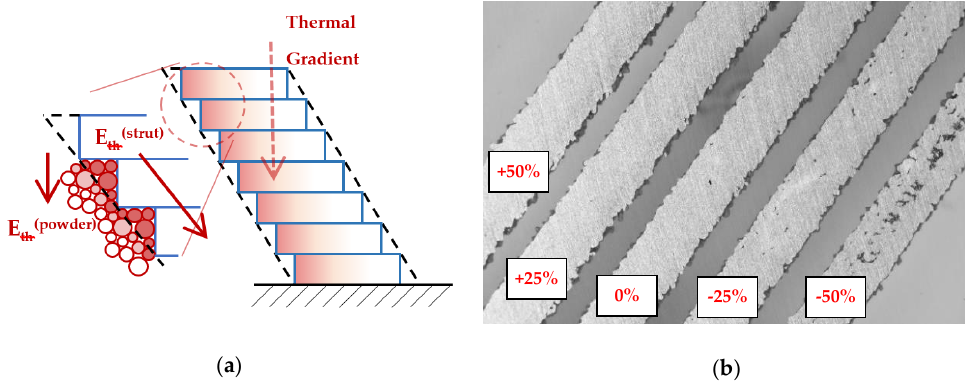
Figure 18. ( a ) Scheme of the heat transfer during SLM additive manufacturing; ( b ) The ground sample to the mid-plane of the struts.